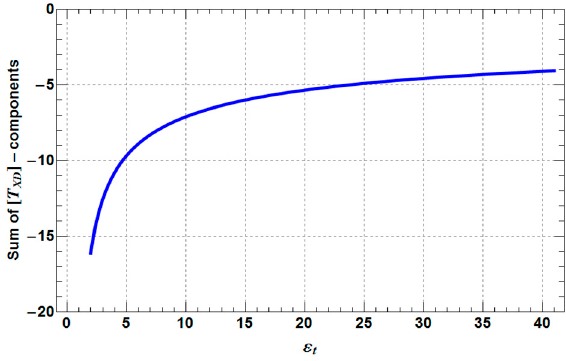
the soil ε s ; blue: θ 1 = 30°, ε t = 10; red: θ 1 = 50°, ε t = 10 and ω l = 30°, L SXD = 1, ϕ = 0°.